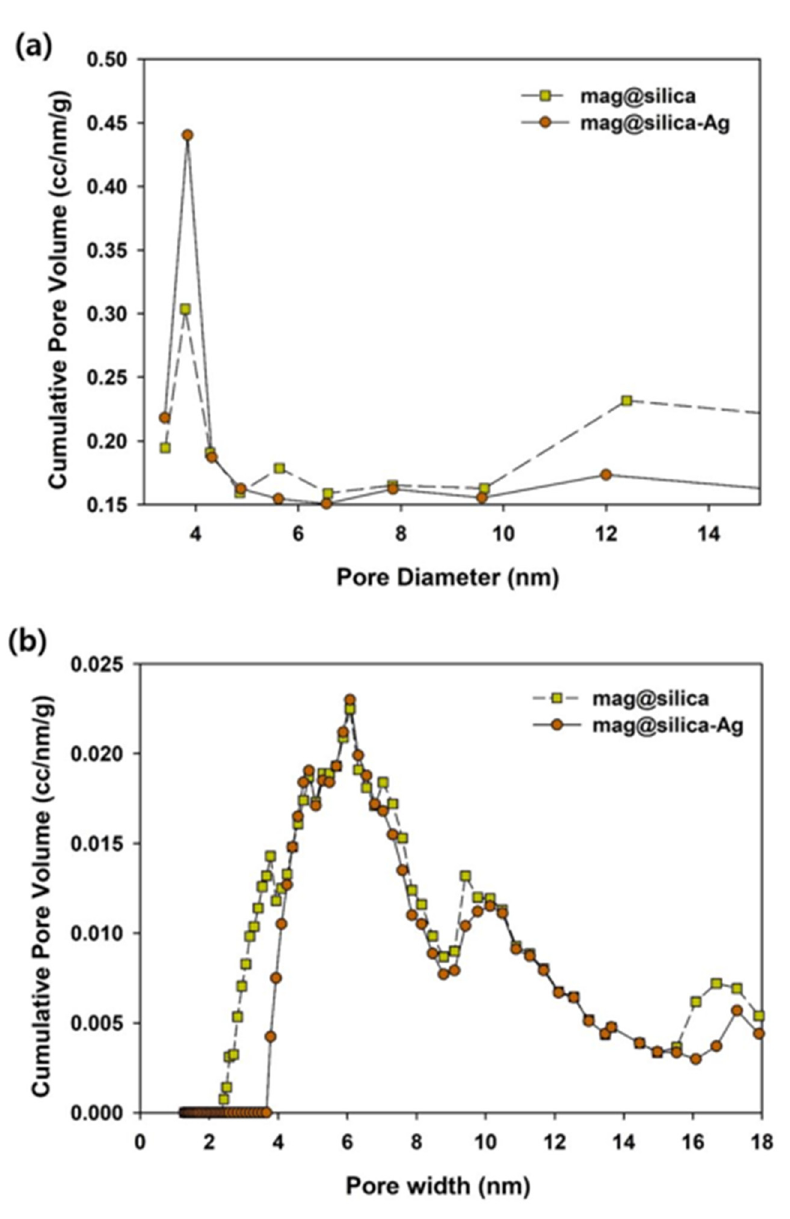
Figure 5. ( a ) Barrett–Joyner–Halenda (BJH) pore size distribution curves for the mag@silica and mag@silica-Ag, ( b ) the density functional theory (DFT) pore size distribution curves for the